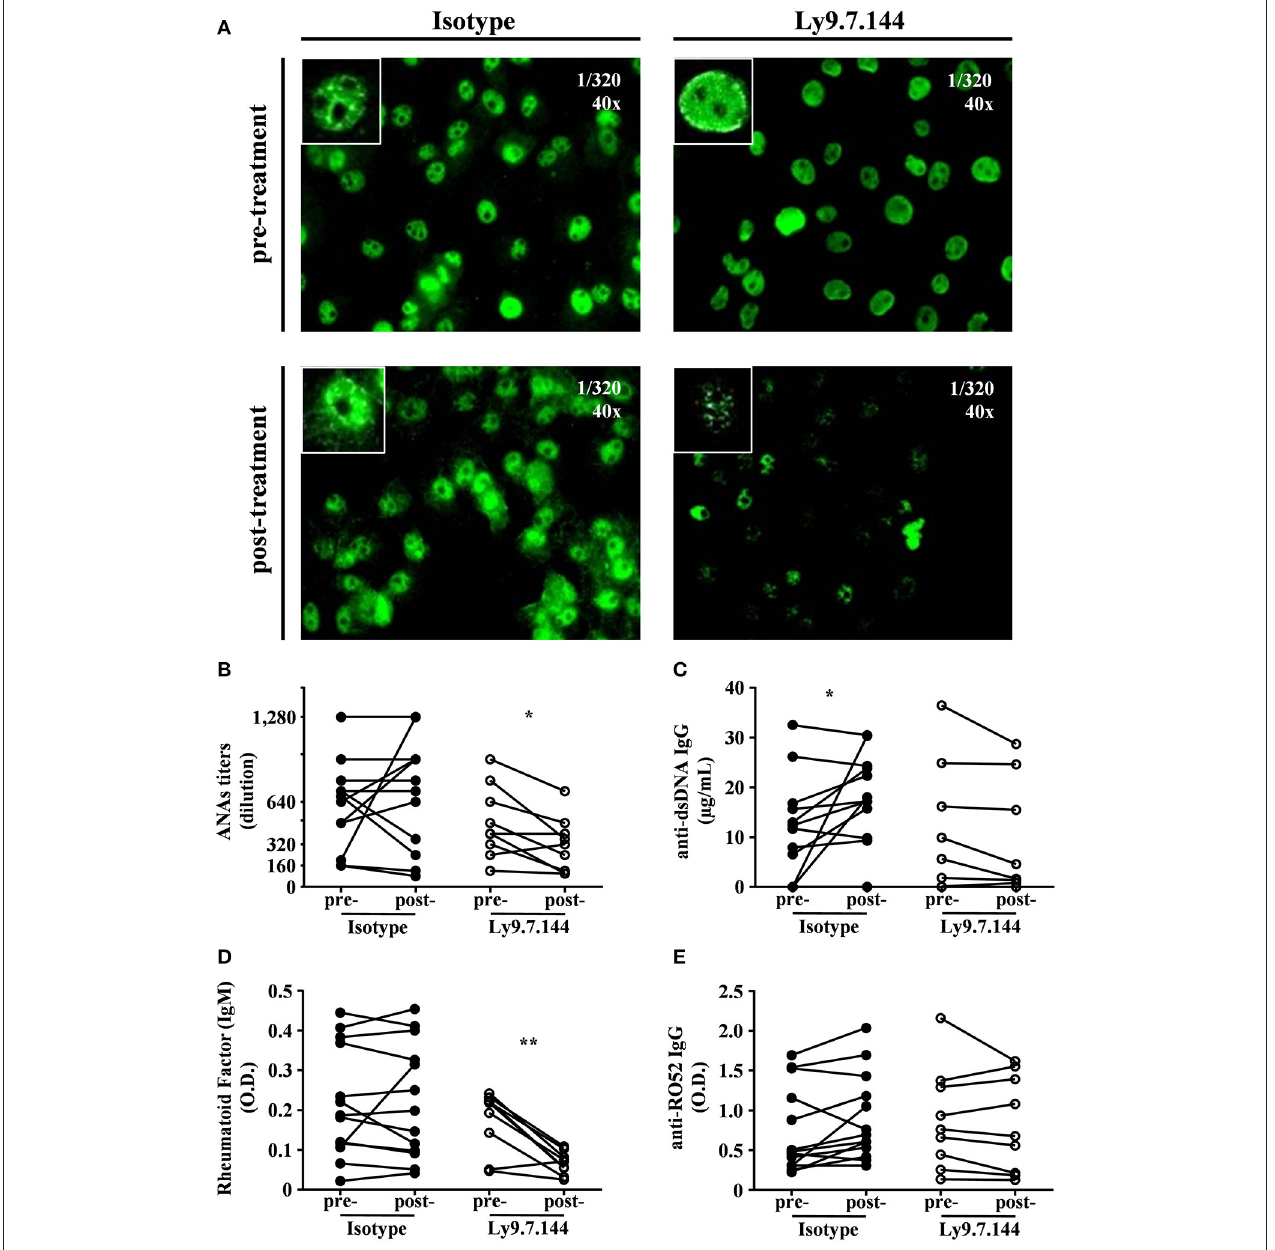
FIGURE 8 | Ly9.7.144 mAb is capable to affect serum autoantibody levels in SjS mice . Photographs of representative ANAs titers (A) from pre- (upper panels) and post- (down panels) treatment either with isotype (left panels) or Ly9.7.144 (right panels) mAb are shown. ANAs IgG titers (B) , anti-dsDNA IgG (C) , rheumatoid factor IgM (D) , anti-Ro52 IgG (E) autoantibody levels are presented from sera of female NOD.H-2 h4 mice previous to treatment (24-weeks-old) and after treatment (30-weeks-old). Mice treated with Ly9.7.144 mAb are represented as empty dots and mice treated with isotype control are represented as black dots. To exemplify ANAs the same titer was used at 40 magnifications as specified at the upper right corner of each photograph. Results are expressed as paired values (B–E) .* p < 0.05; ** p < 0.01 (paired two-tailed t -test). Data are pooled from four independent experiments.